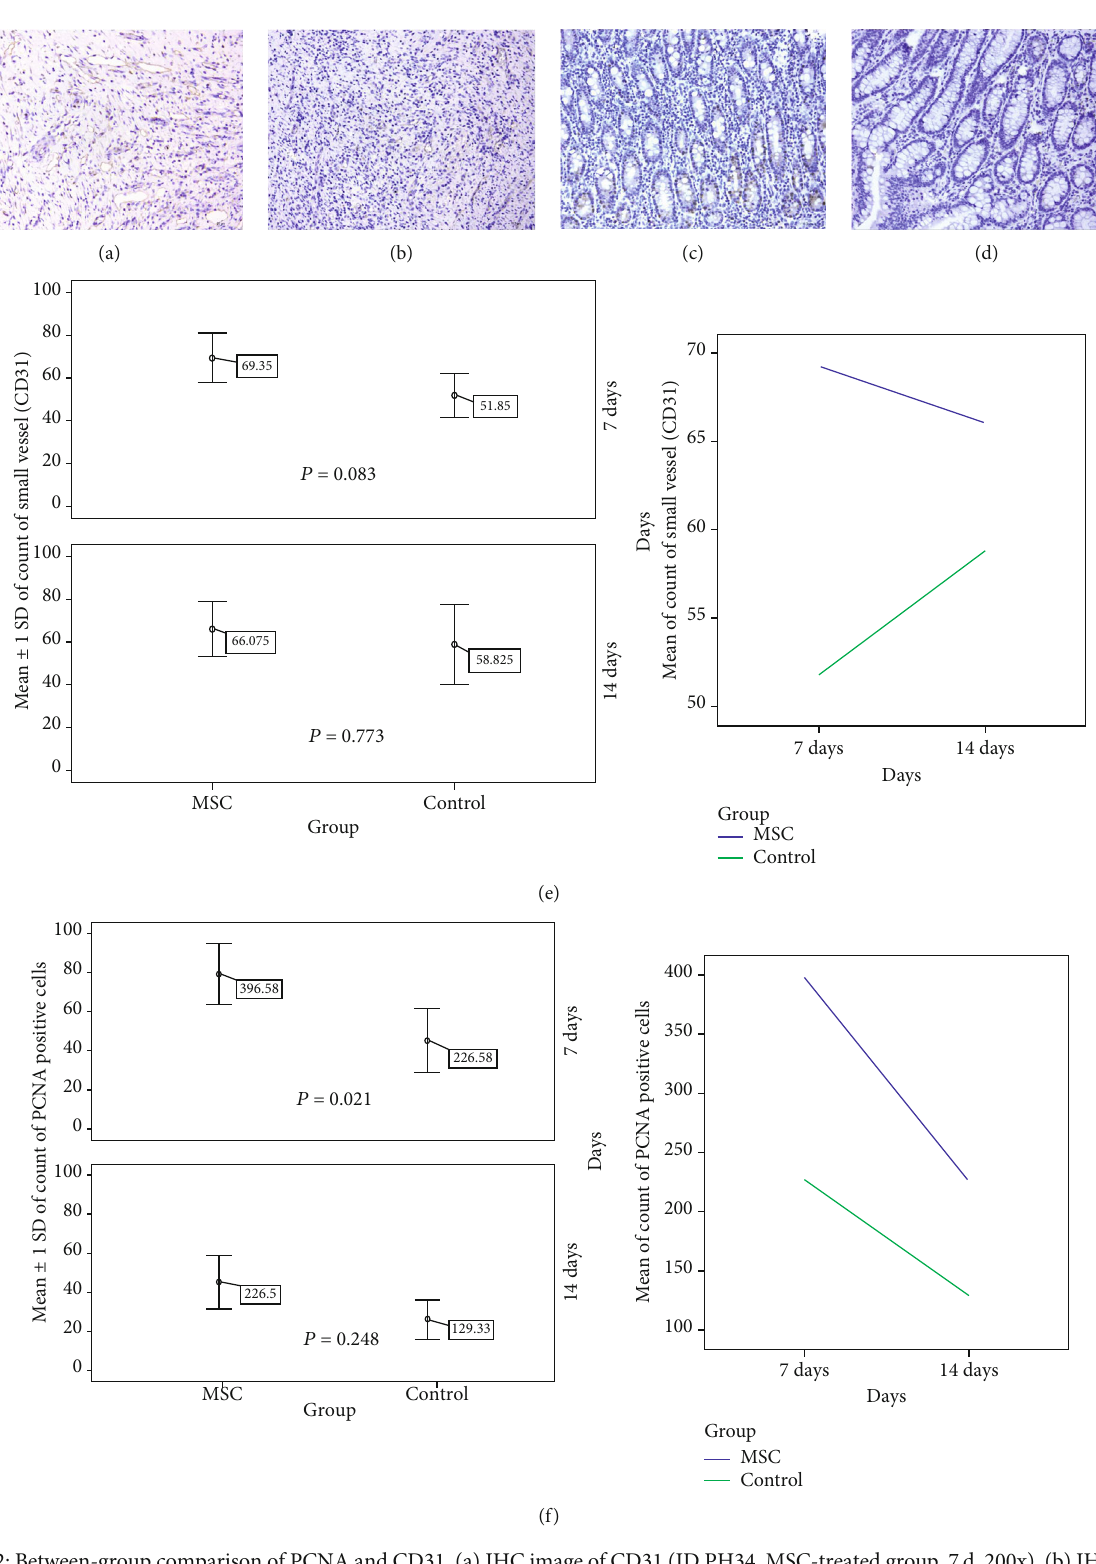
Figure 2: Between-group comparison of PCNA and CD31. (a) IHC image of CD31 (ID PH34, MSC-treated group, 7d, 200x). (b) IHC image of CD31 (ID PH36, control group, 7d, 200x). (c) IHC image of PCNA (ID PH37, MSC-treated group, 7d, 200x). (d) IHC image of PCNA (ID PH36, control group, 7d, 200x). (e) Between-group comparison of the number of CD31-stained small vessels ( n = 4 ). (f) Comparison of the number of PCNA-positive cells between the two groups ( n = 4